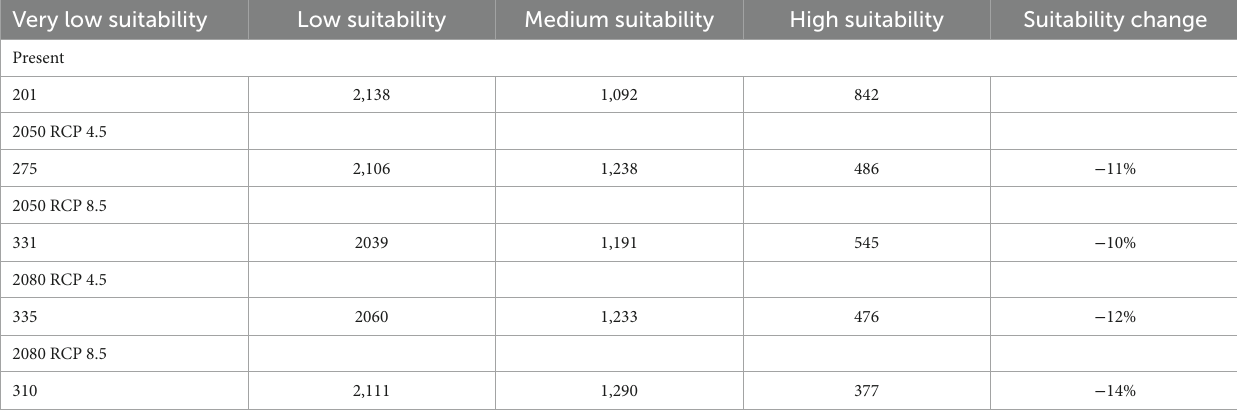
TABLE 6 Suitable habitat in km 2 and variation in percentage, for the tree species Faidherbia albida in Cabo Verde, under two climate change scenarios (RCP 4.5 and RCP 8.5), based on climatic modelling. Very low